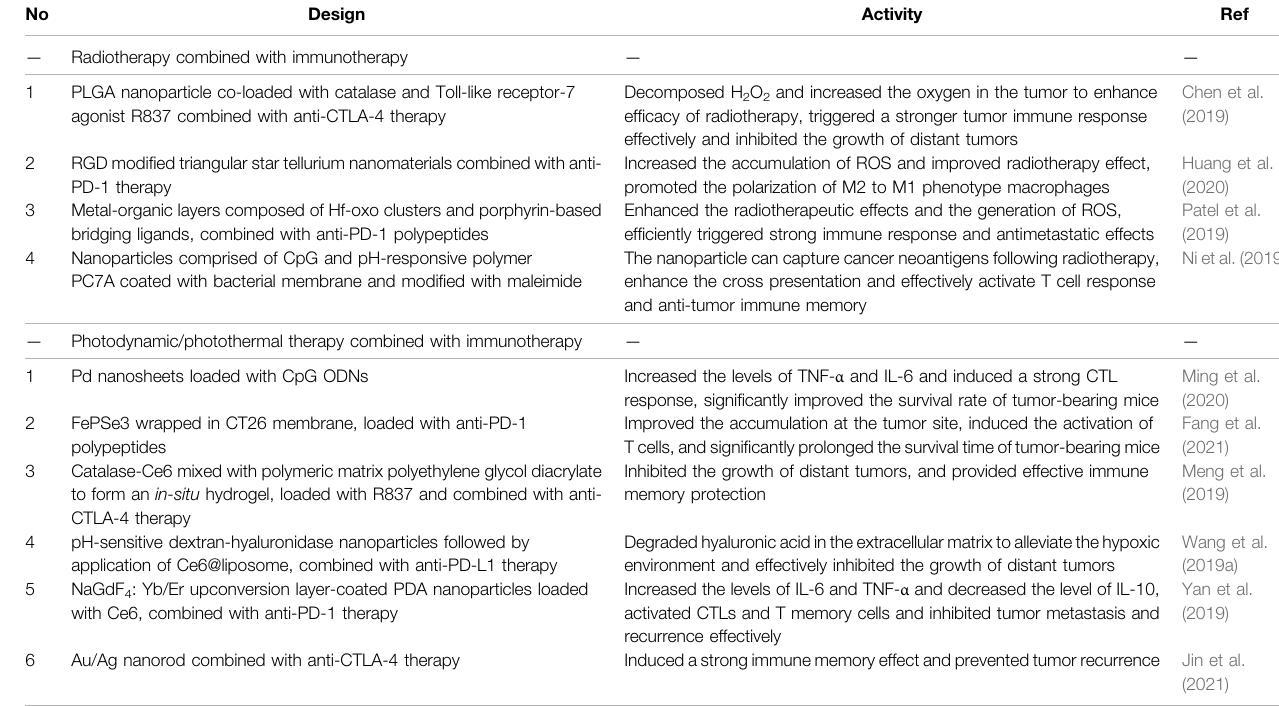
TABLE 1 | List of nanomaterials in tumor combination therapy based on